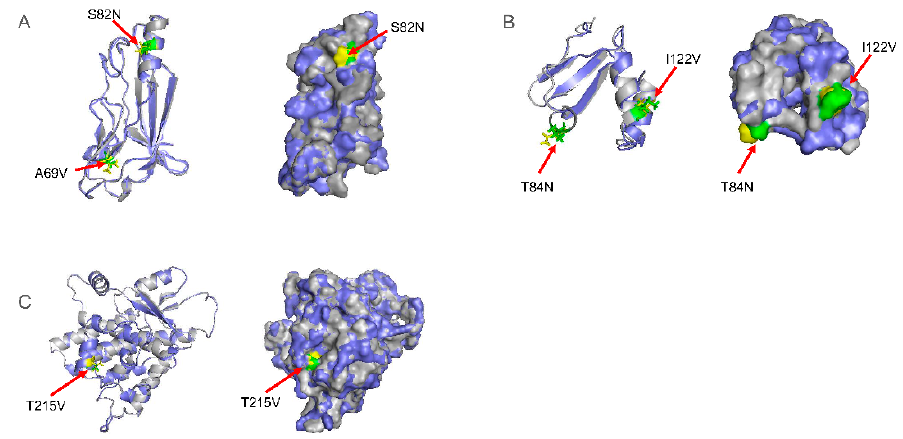
Figure 2. Predicated 3D structures of gD ( A ), gL ( B ), and TK ( C ) proteins. Bartha is marked as gray, and JL-CC is labeled by slate. Different amino acids of Bartha and JL-CC strains are highlighted in green and yellow, respectively.